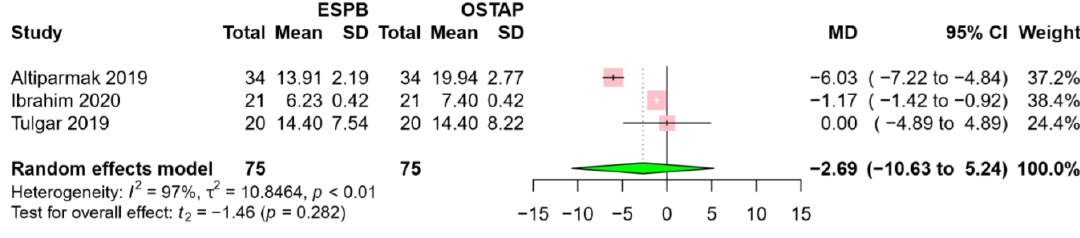
Figure 7. Forest plot for pain scores: ( a ) postoperative 12 h, ( b ) postoperative 24 h. Postoperative pain scores were comparable between the ESPB group and the OSTAP group. Abbreviations: ESPB, erector spinae plane block; OSTAP, oblique subcostal transversus abdominis plane block; MD, mean difference; SD, standard deviation; CI, confidence interval . Figure 8. Forest plot for postoperative nausea and vomiting. The incidence of PONV was similar between the ESPB group and the OSTAP group. Abbreviations: ESPB, erector spinae plane block; OSTAP, oblique subcostal transversus abdominis plane block; OR, odds ratio; CI, confidence interval.